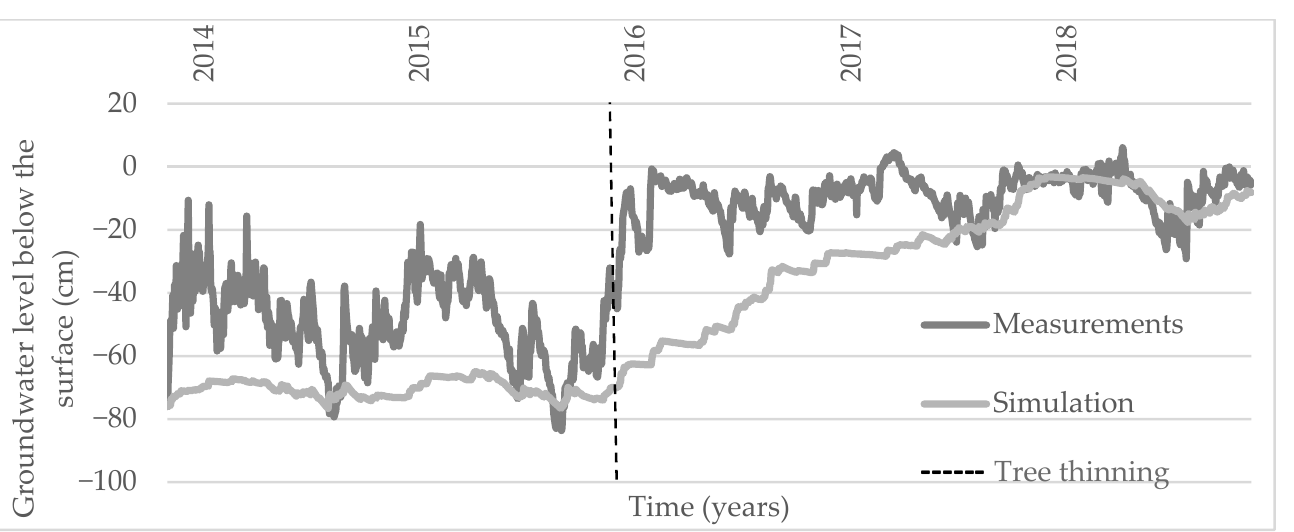
Figure 8. Groundwater level estimates for plot 4 after adjusting the precipitation parameter to in- clude the water supply from surface runoff.